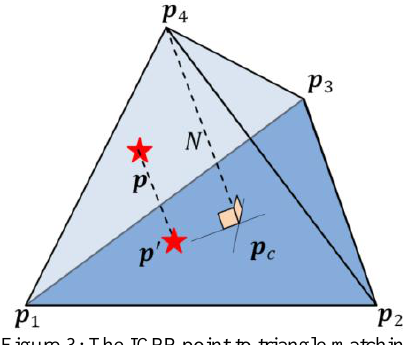
Figure 3: The ICPP point to triangle